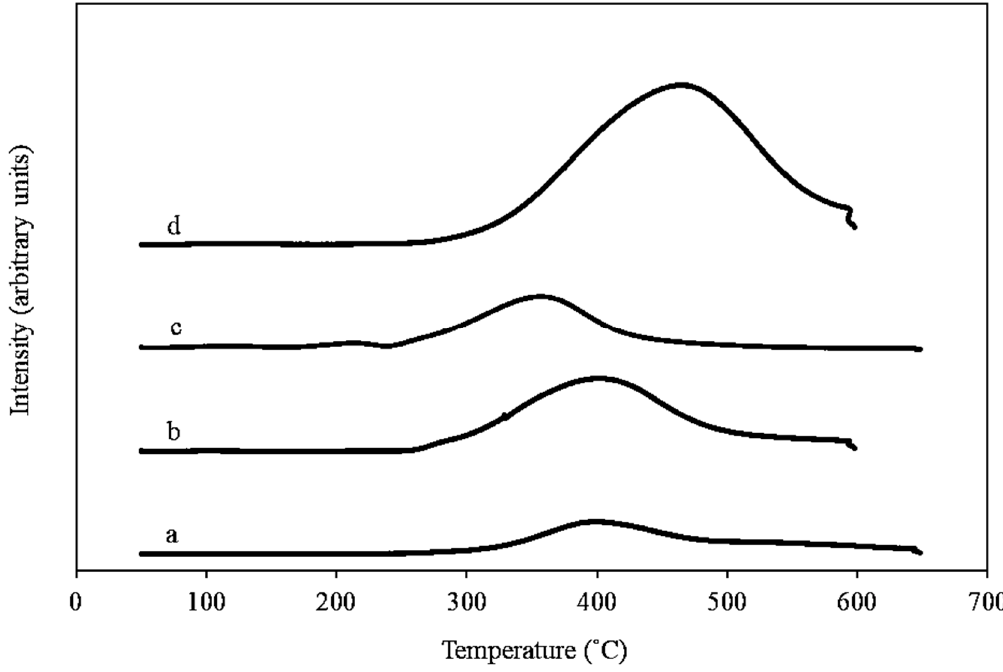
Figure 2. H 2 -TPR profiles of the catalysts of 25 wt % Ni/Ce–Mg (9:1 mol/mol), ( a ) by impregnation and calcined at 550 °C, ( b ) by DP and calcined at 550 °C, ( c ) by DP and calcined at 350 °C, and ( d ) by and calcined at 550 ◦ C, ( b ) by DP and calcined at 550 ◦ C, ( c ) by DP and calcined at 350 ◦ C, and ( d ) by DP and calcined at 650 °C. DP and calcined at 650 ◦